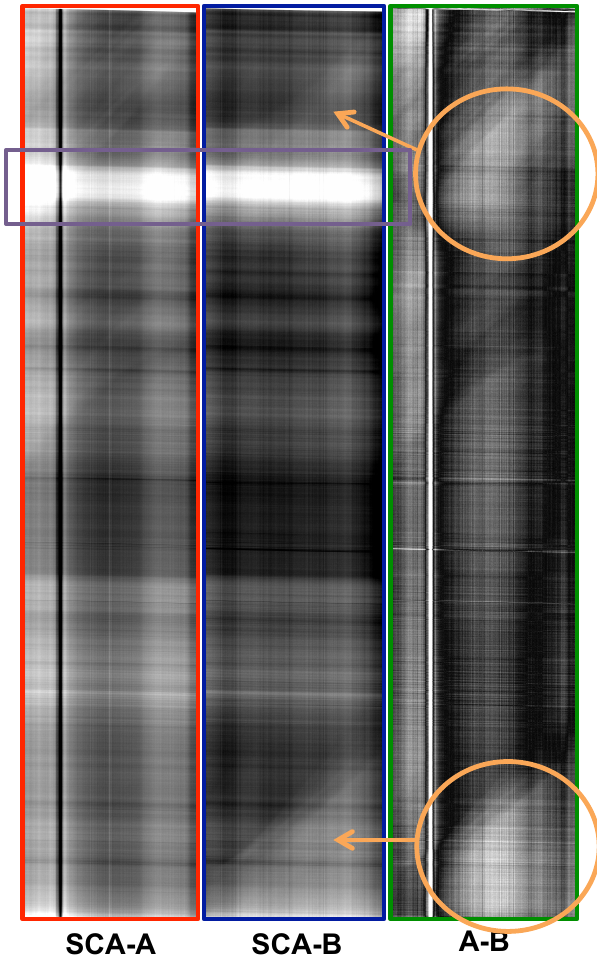
Figure 17. Artifacts due to stray light are present in TIRS band 11 side slither image data. ( Left ) shows horizontally corrected SCA-A side slither data, ( middle ) shows horizontally corrected SCA-B side slither data, and ( right ) shows the difference image. Significant artifacts exist in the orange circles indicating the presence of stray light. The purple square highlights a landmass (Cyprus) which is appropriately removed in the difference image